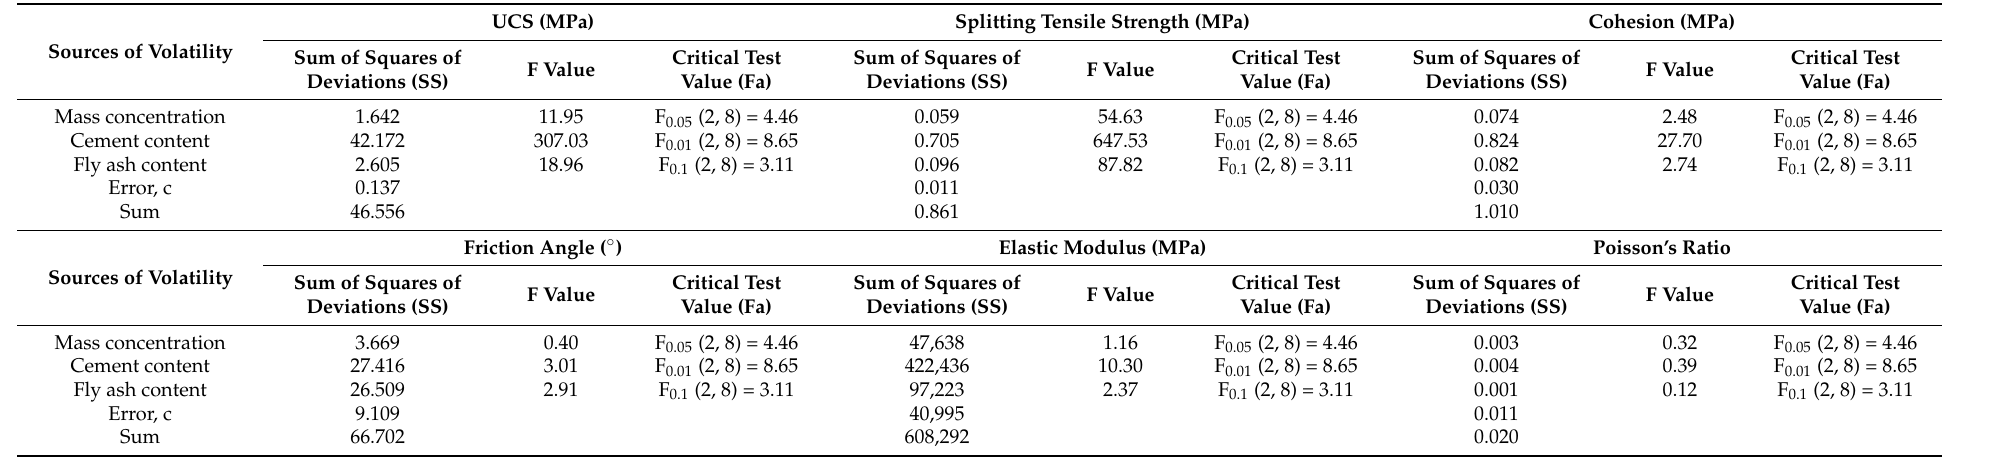
Table 9. Variance analysis of factors influencing mechanical properties of gangue paste